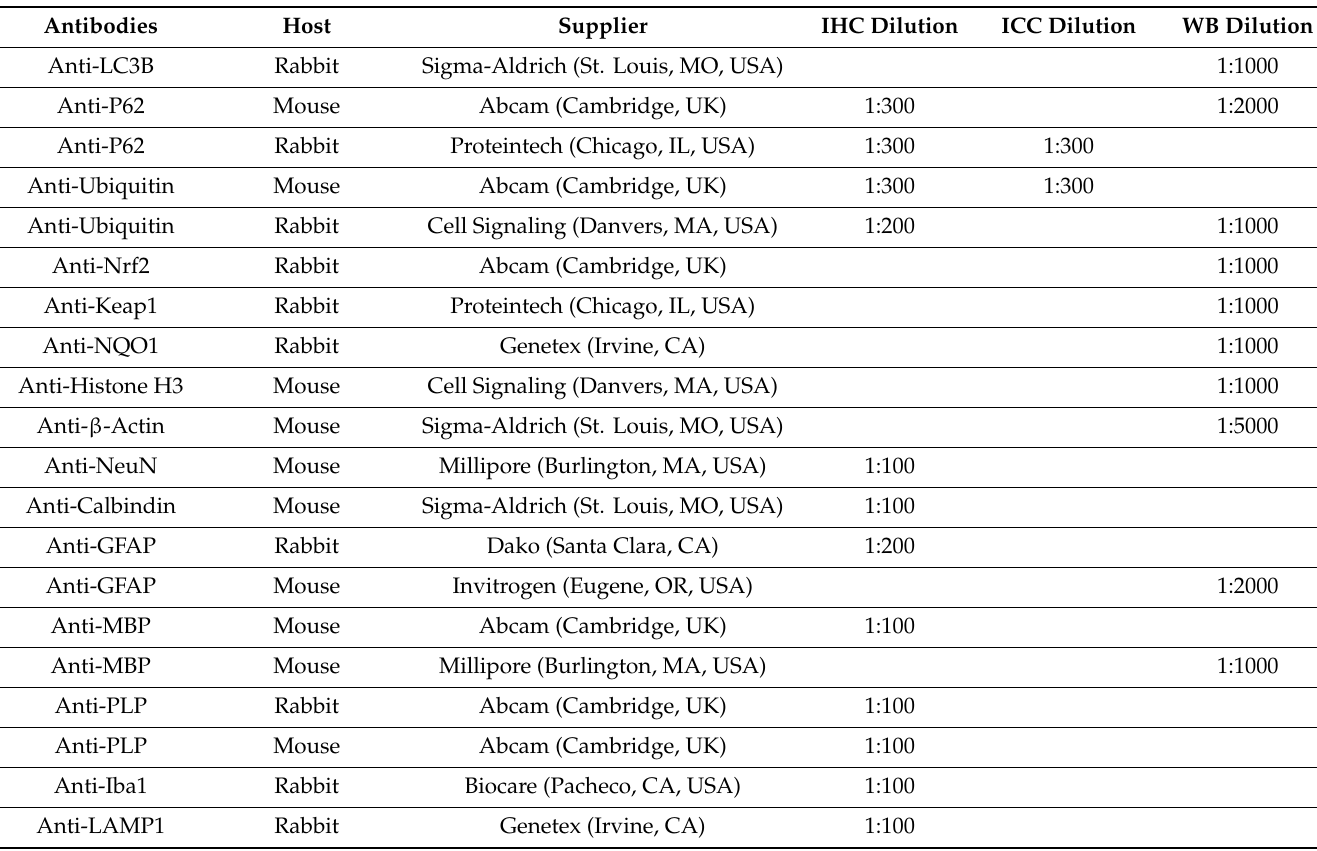
Table 1. List of primary antibodies for immunohistochemistry (IHC), immunocytochemistry (ICC), and Western blot (WB) analyses. Antibodies Host